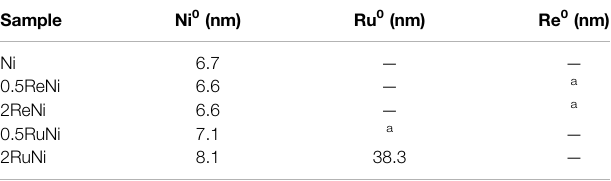
TABLE 2 | Crystallite size of metal oxides and reduced metals.